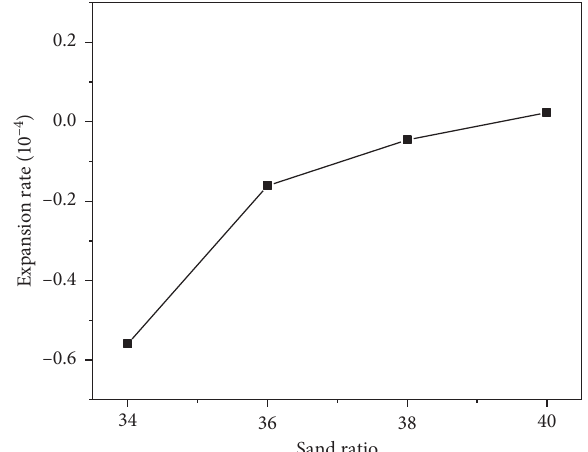
Figure 11: The impact of the content of coarse steel slag on the compressive strength of the FSSAC.